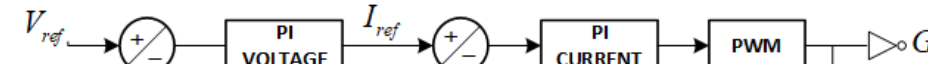
Figure 6. Bidirectional Converter “Buck–Boost”.